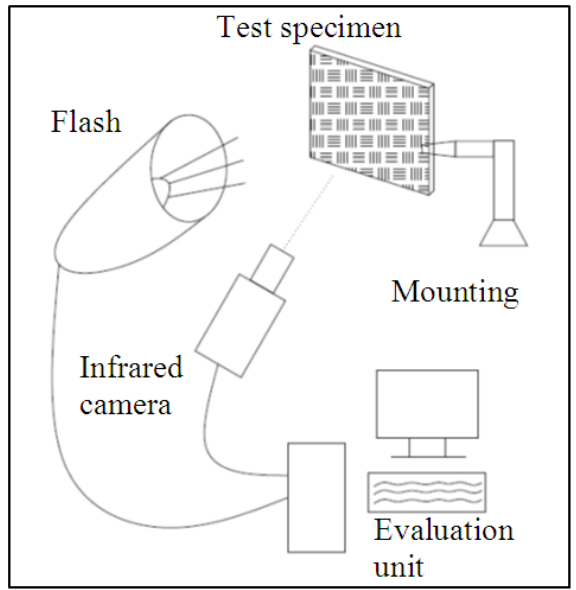
Figure 3. Thermography analysis testing